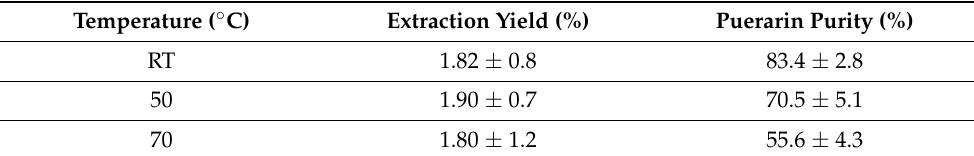
Table 3. The effect of temperature on the yield and the purity of puerarin extract.